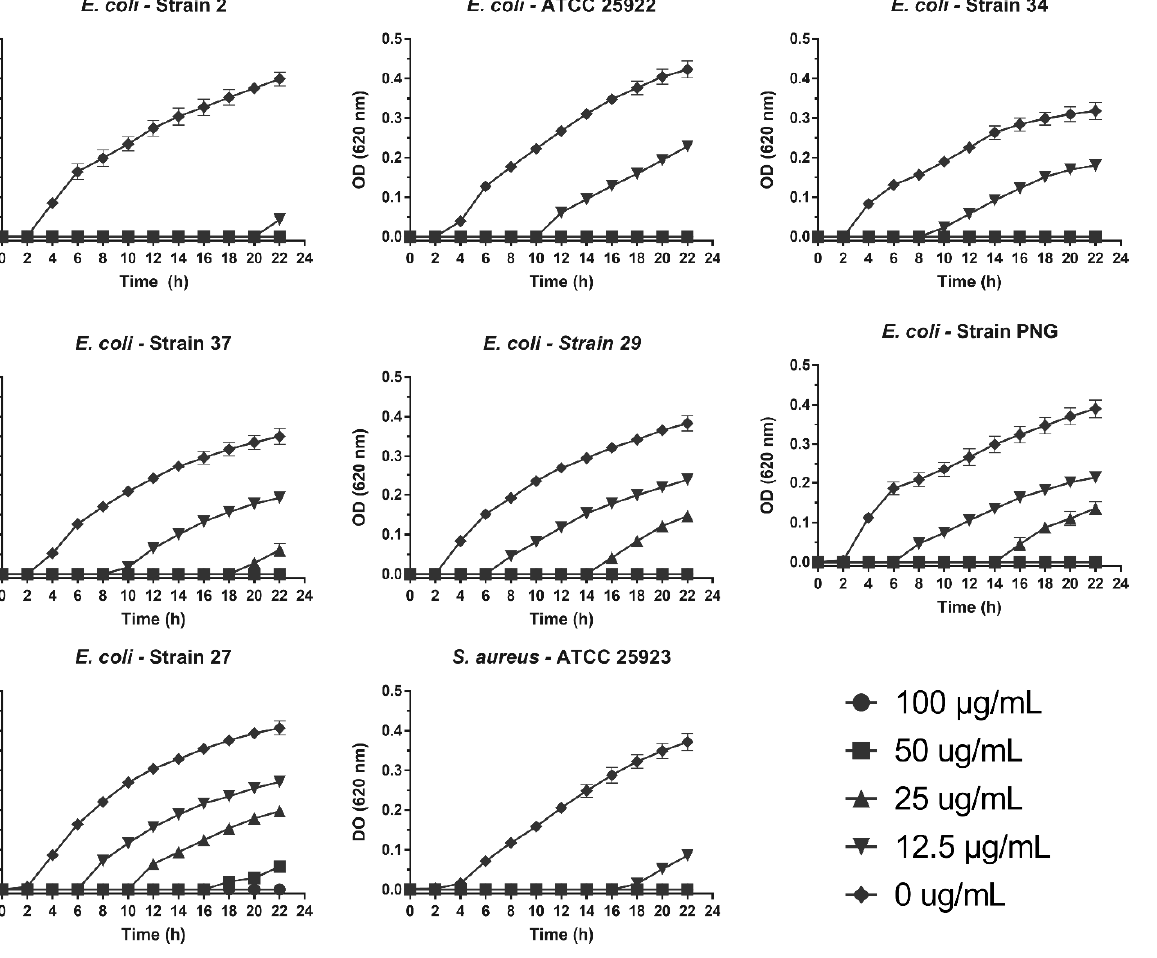
Figure 5. Antibacterial activity of SPw-AgNPs against ATCC and clinical isolates of multi-drug resistant bacteria. Bacteria were tested with different doses of SPw-AgNPs (100–12.5 µ g/mL). Data represent the mean of three independent experiments ± standard deviation.